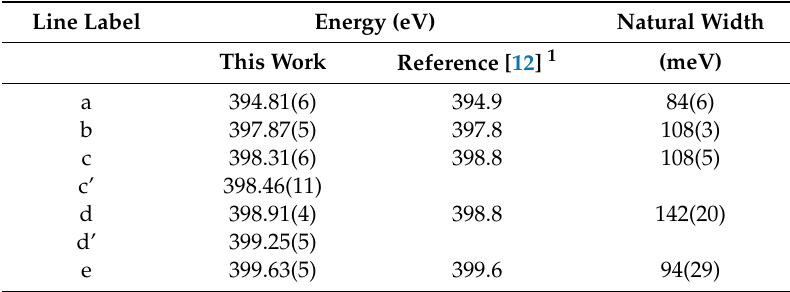
Table 3. Experimental position and natural width of the lines observed in the 394–401 eV photon energy region.